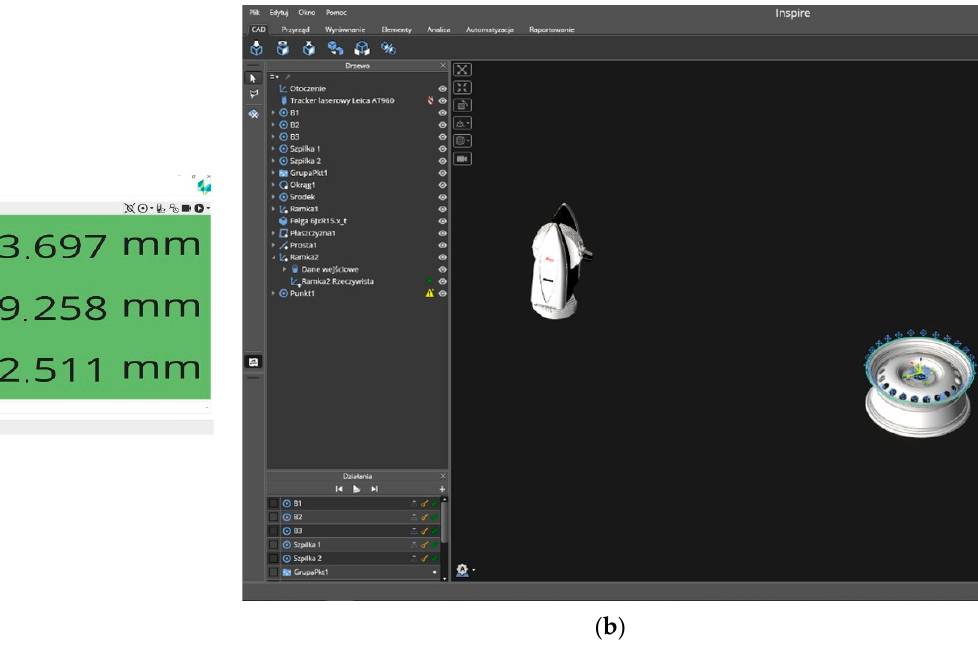
Figure 2. Available tracker software: ( a ) Tracker Pilot software window; ( b ) Inspire software window.